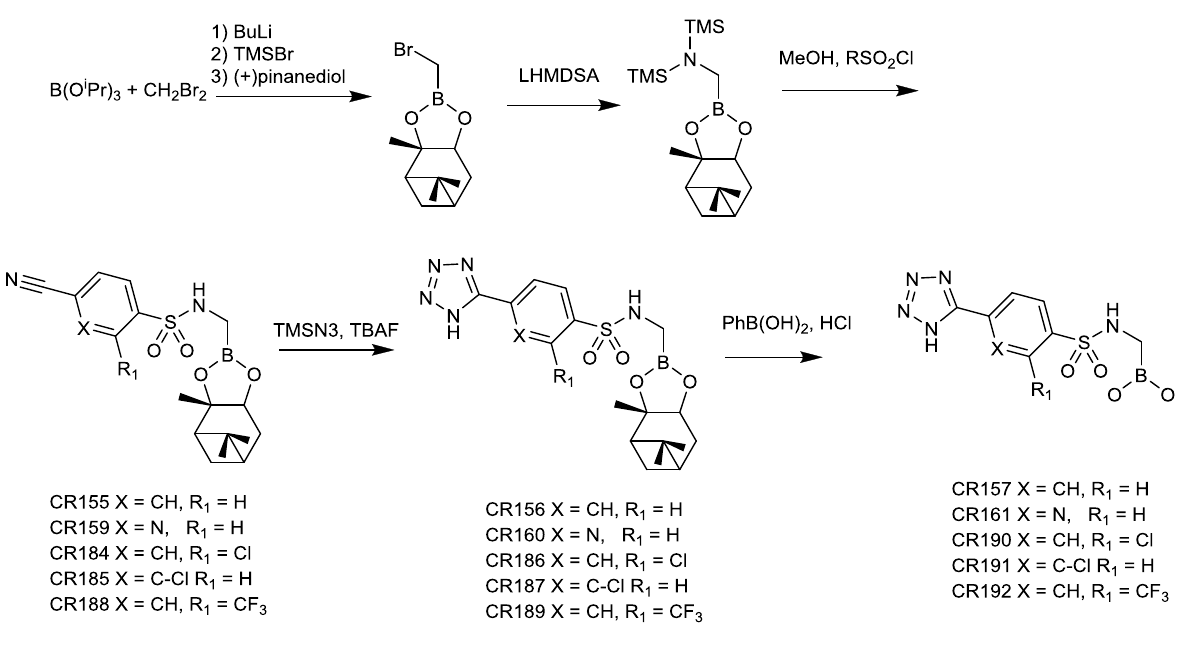
Figure 13. Synthesis of some sulfonamido boronic acids.